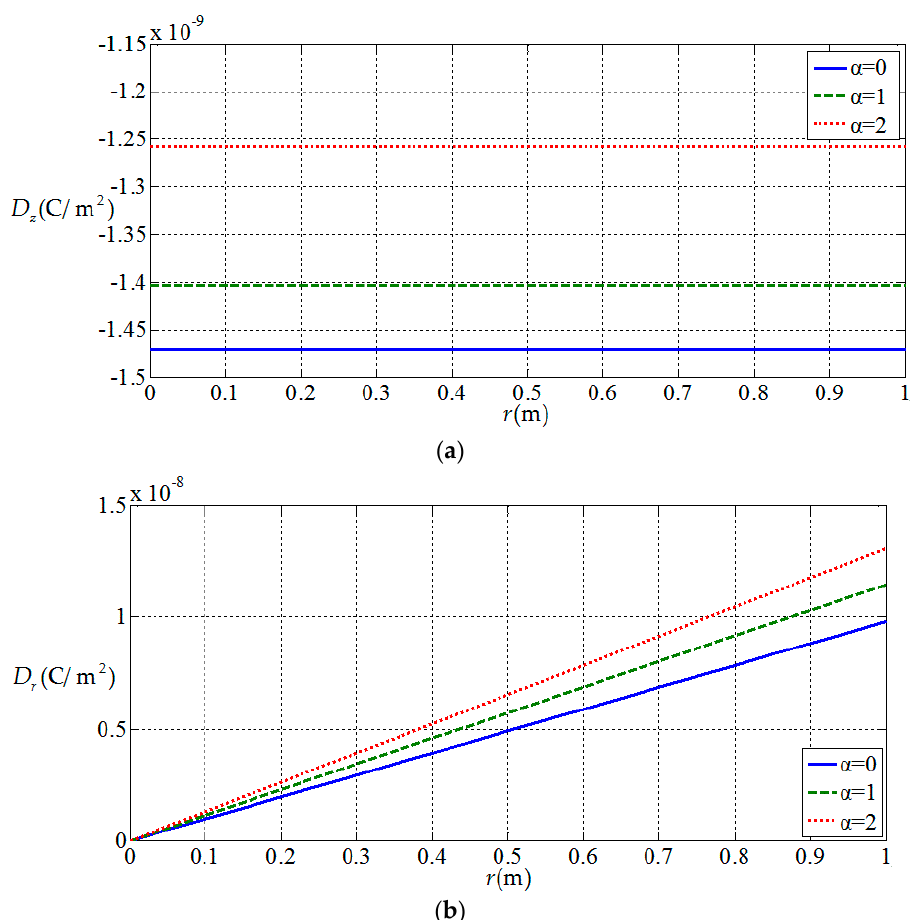
Figure 12. Variation of electric displacement with coordinates r at z = h /4. ( a ) Electric displacement D z ( r , h /4 ) at z = h /4; ( b ) electric displacement D r ( r , h /4 ) at z = h